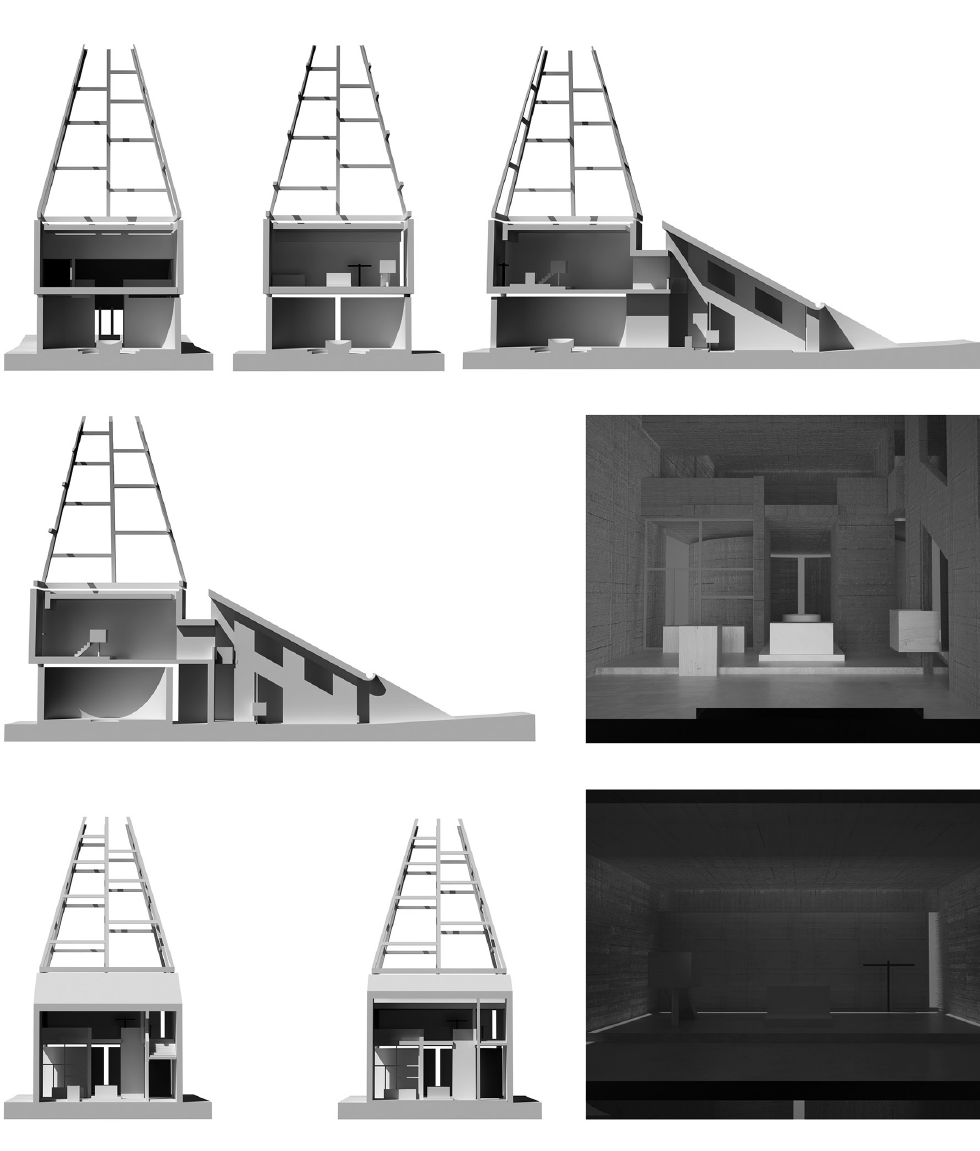
Fig. 4 A. Tortorici, Sections and renderings of the graphic interpretation of the church project for Bologna,